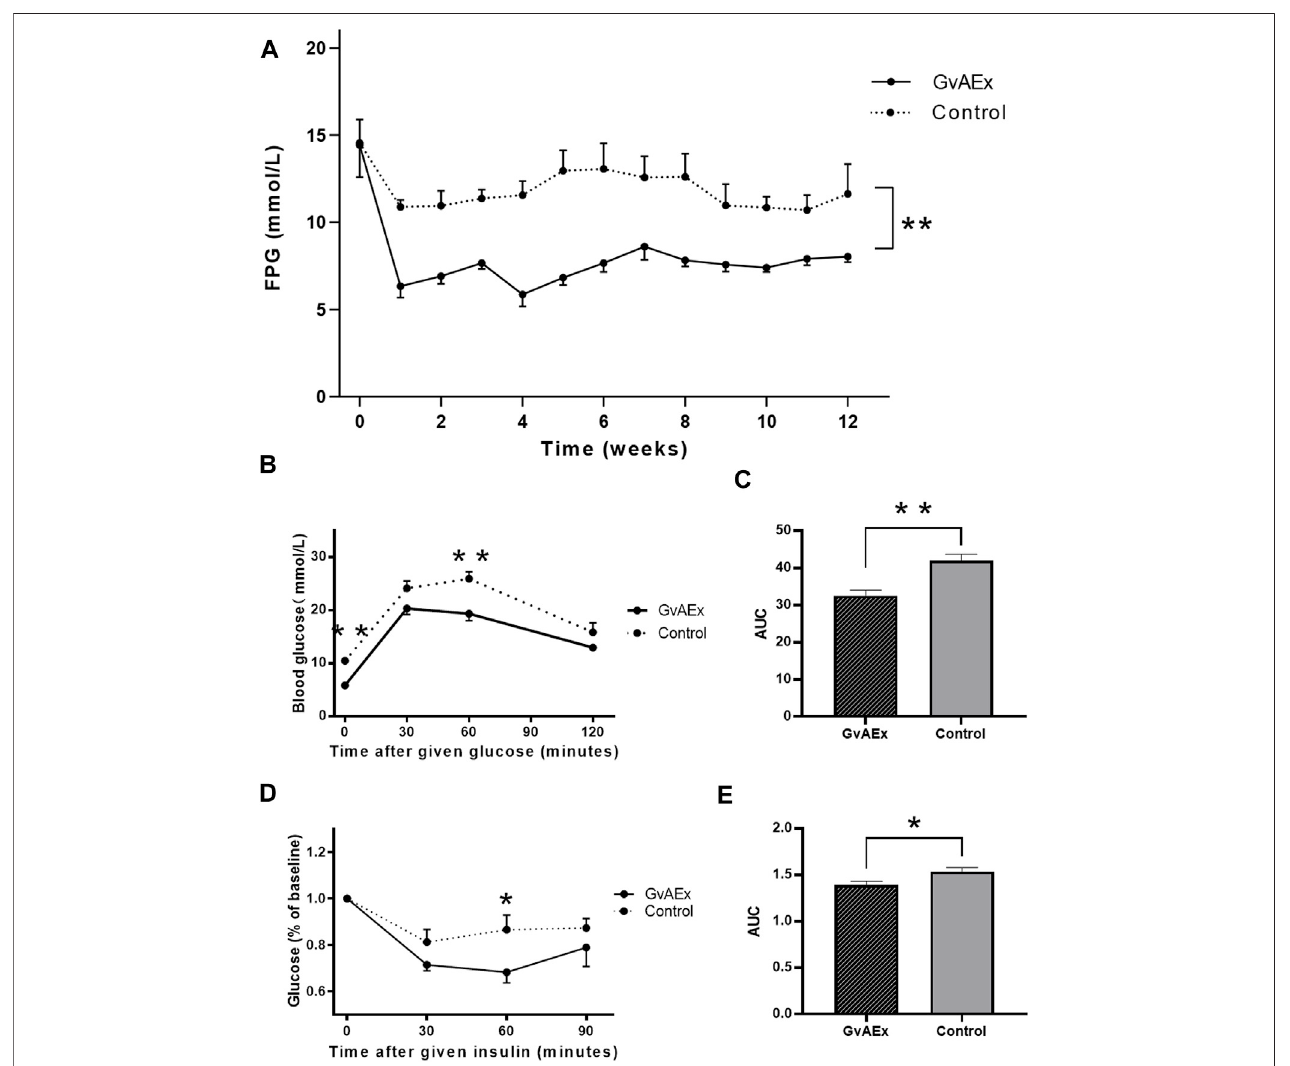
FIGURE 1 | GvAEx treatment lowers blood glucose in a dosage-dependent manner in db/db mice. (A) Fasting plasma glucose (FPG) levels of male db/db mice treatedwithGvAExorvehiclefor12 weeks( n =6/group). (B) Bloodglucoselevelsinthedb/dbmicetreatedwithGvAExorvehicleasdeterminedbyIPGTT( n =6/group). (C) Area under curve (AUC) from (B) . (D) Blood glucose levels as determined by ITT ( n = 6/group). (E) AUC from (D) . * p < 0.05, ** p < 0.01, *** p < 0.001.